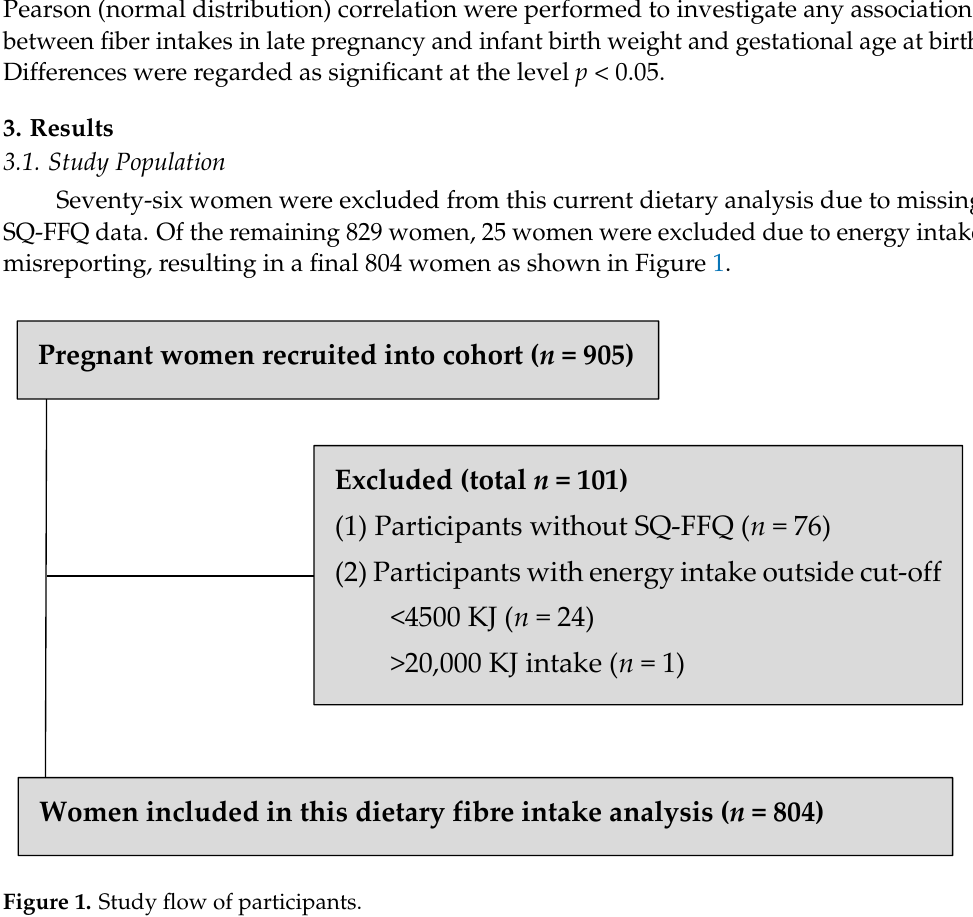
Figure 1. Study flow of participants.